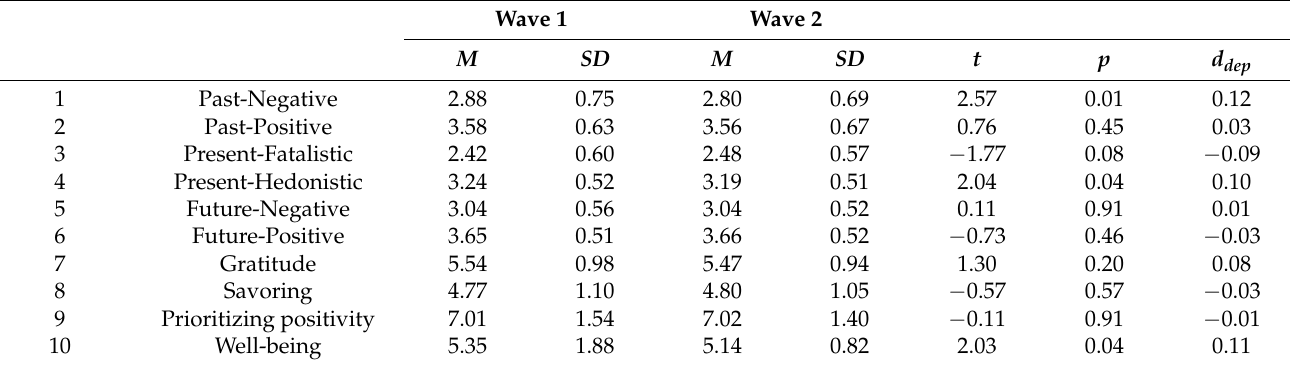
Table A1. Comparison of the means in both waves of the study.